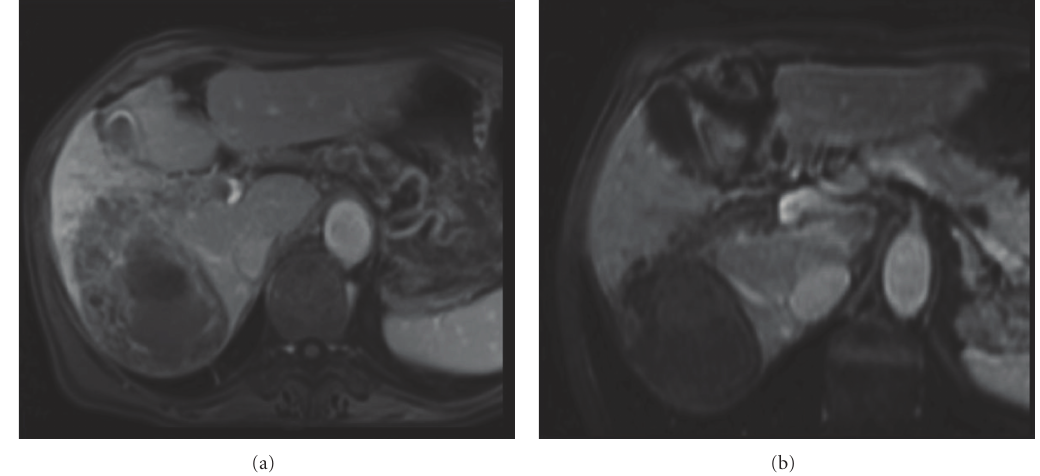
Figure 1: MRI of patient 1. (a) Before treatment. (b) After 9 months of treatment with sorafenib.